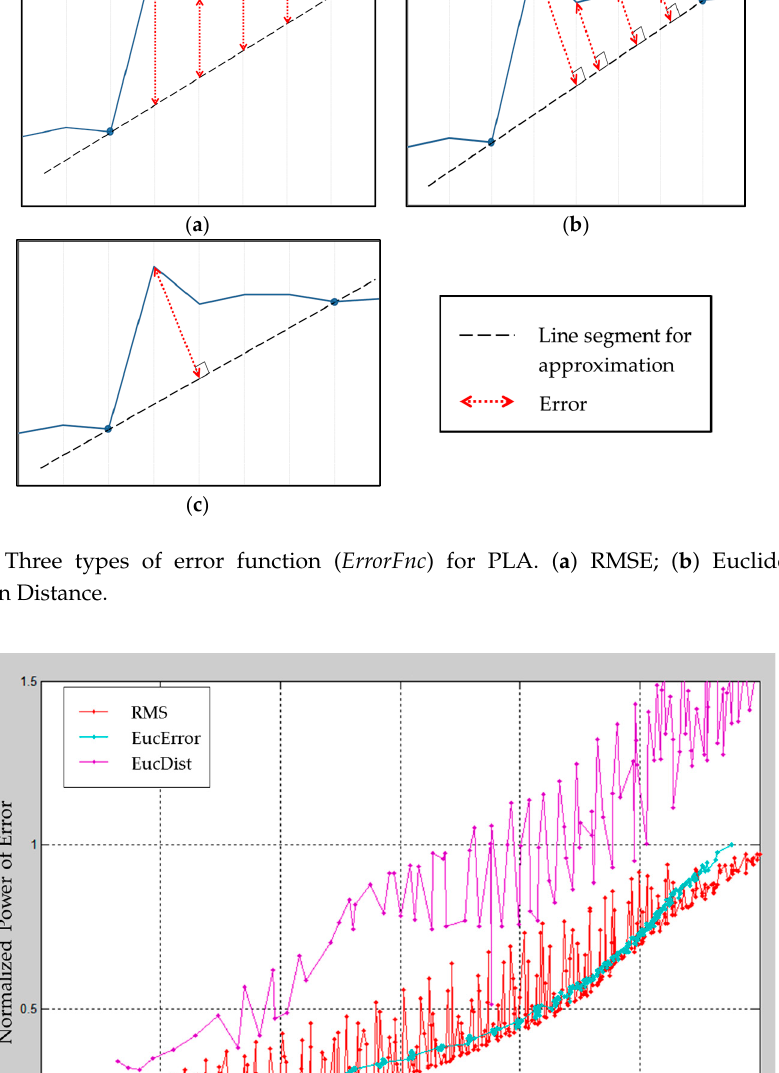
Figure 7. Performance variations according to types of error function.